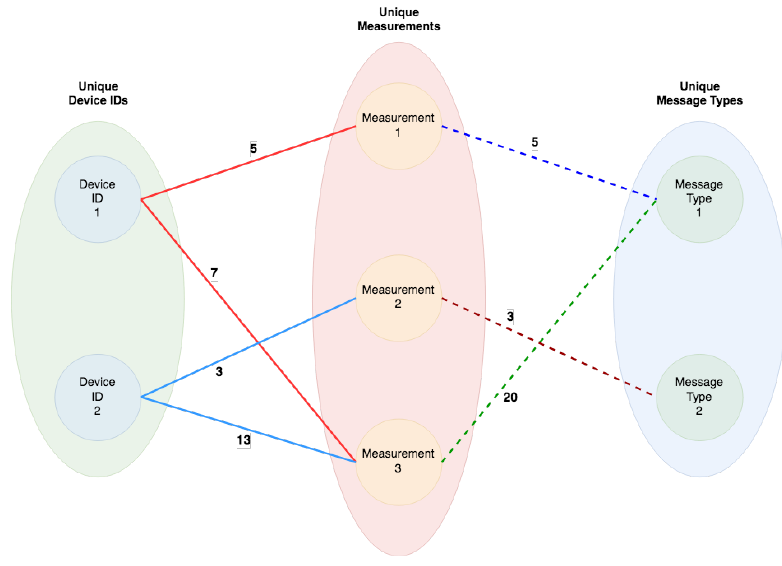
Figure 9. Device message graph